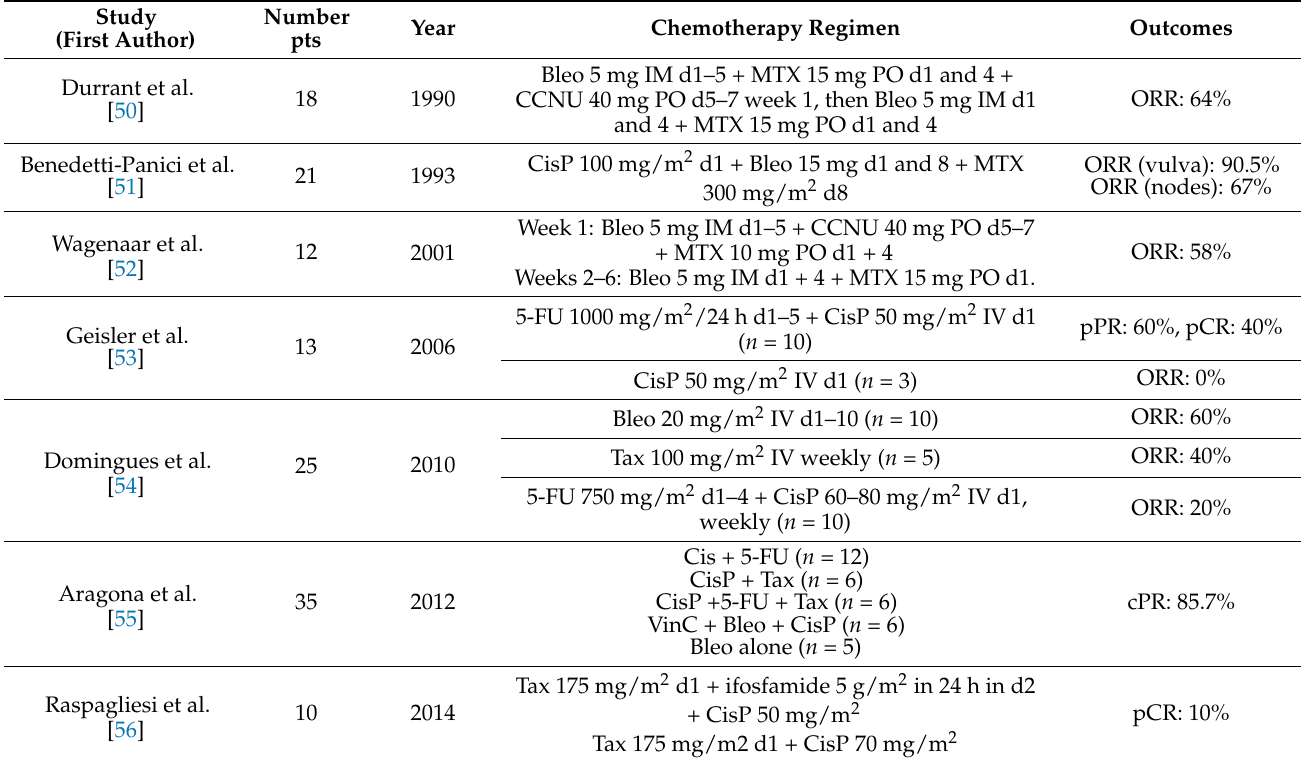
Table 3. Summary of studies with more than 10 patients exploring neoadjuvant chemotherapy in locally advanced vulvar